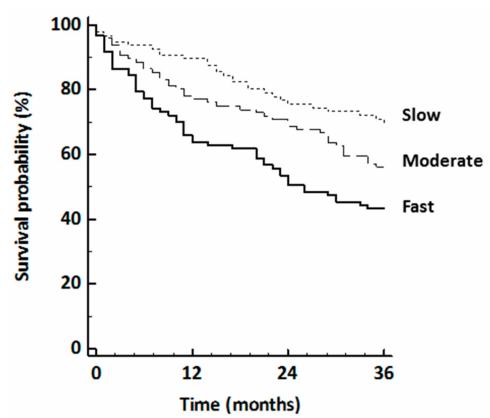
Figure 1. Kaplan–Meier curve showing the rate of hospitalization or death during 36 months after enrolment as a function of walking speed at baseline.